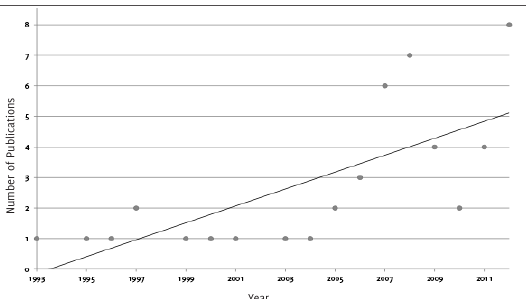
Figure 1. Number of Bibliometric Publications in Latin America, Published in PubMed between 1993 and 2012